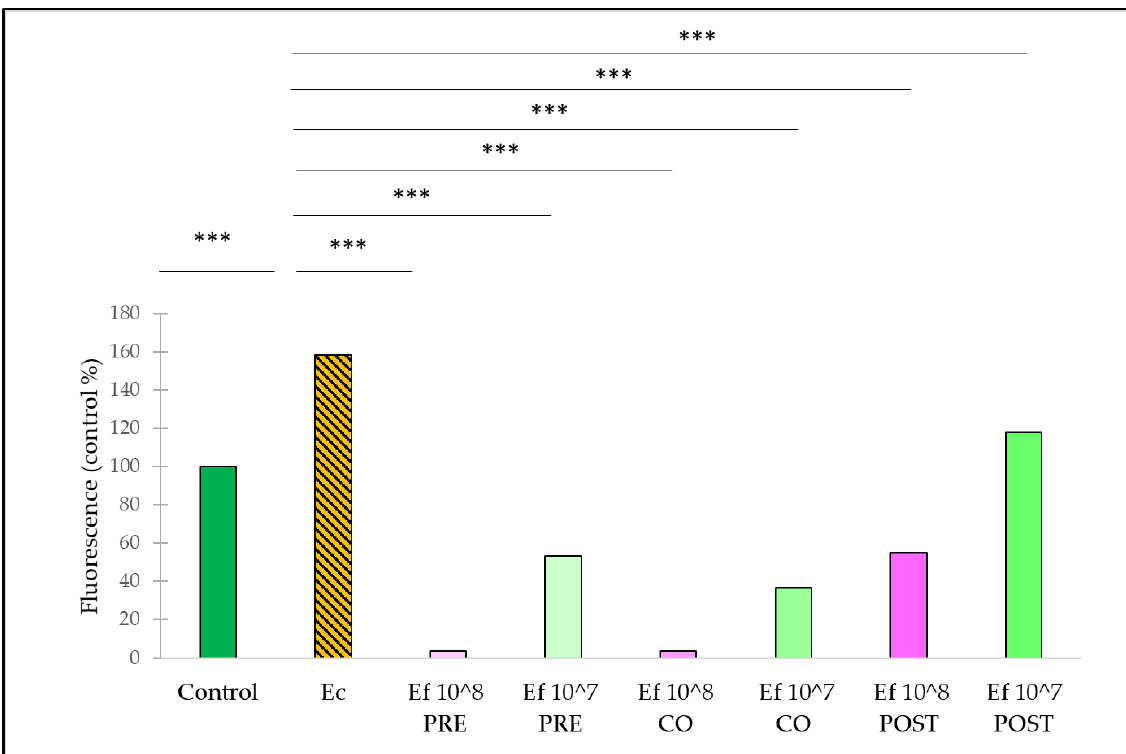
Figure 4. Amount of intracellular ROS after treatment with E. coli and E. faecium . E. faecium